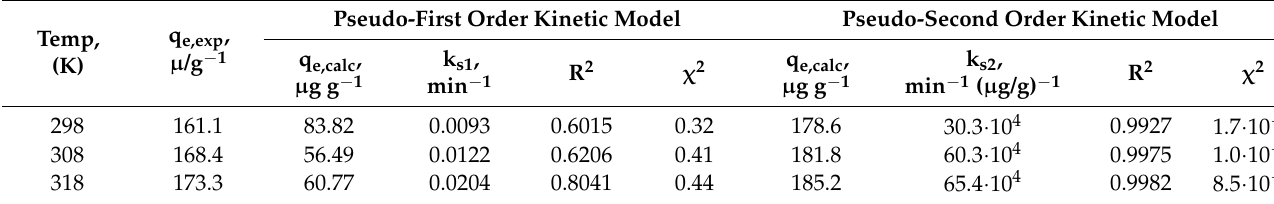
Table 2. Kinetic parameters for the adsorption of As(V) onto material